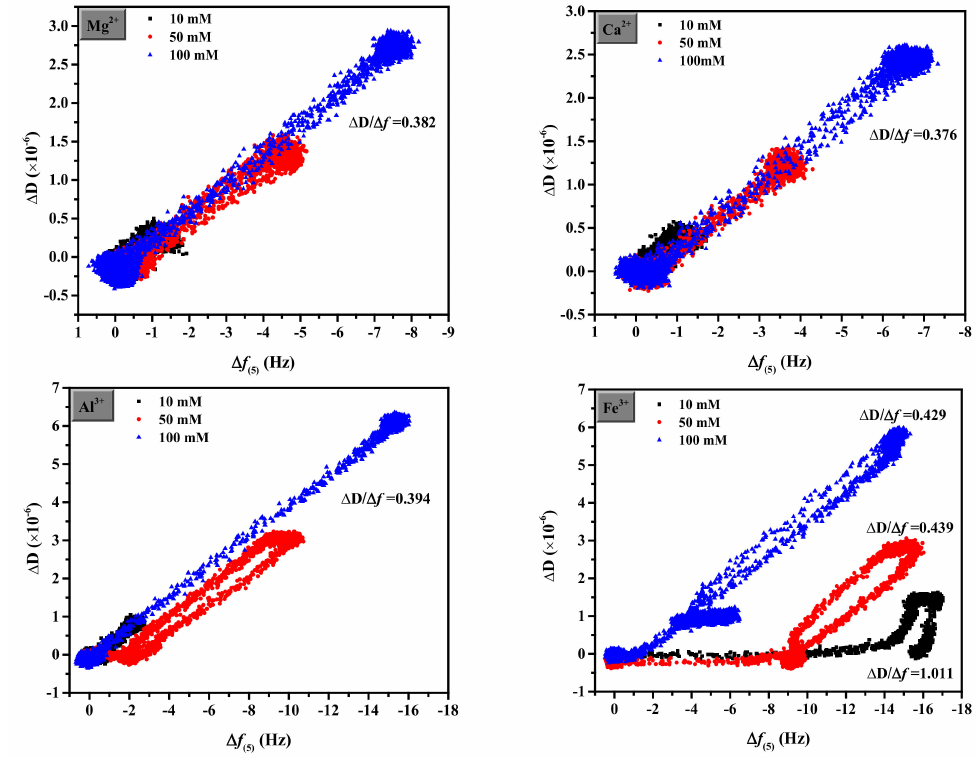
Figure 5. Adsorbed layer properties of different coagulants on QCM-D carbon sensors.